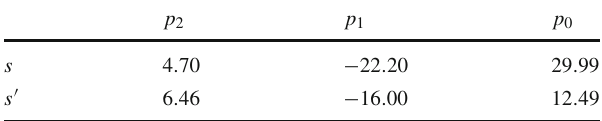
Table 1 Parameters of the parabola parametrization to the hadronic showers shown in Fig. 2 that are used to reconstruct the shower energy from Eq.